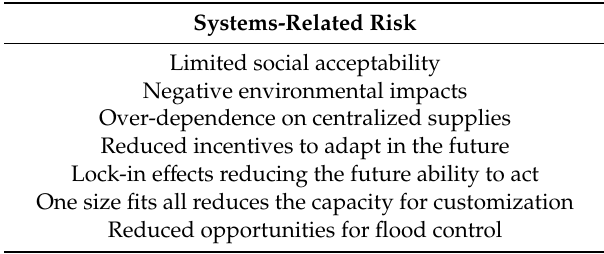
Table 1. Systems-related risks of supply augmentation e ff orts